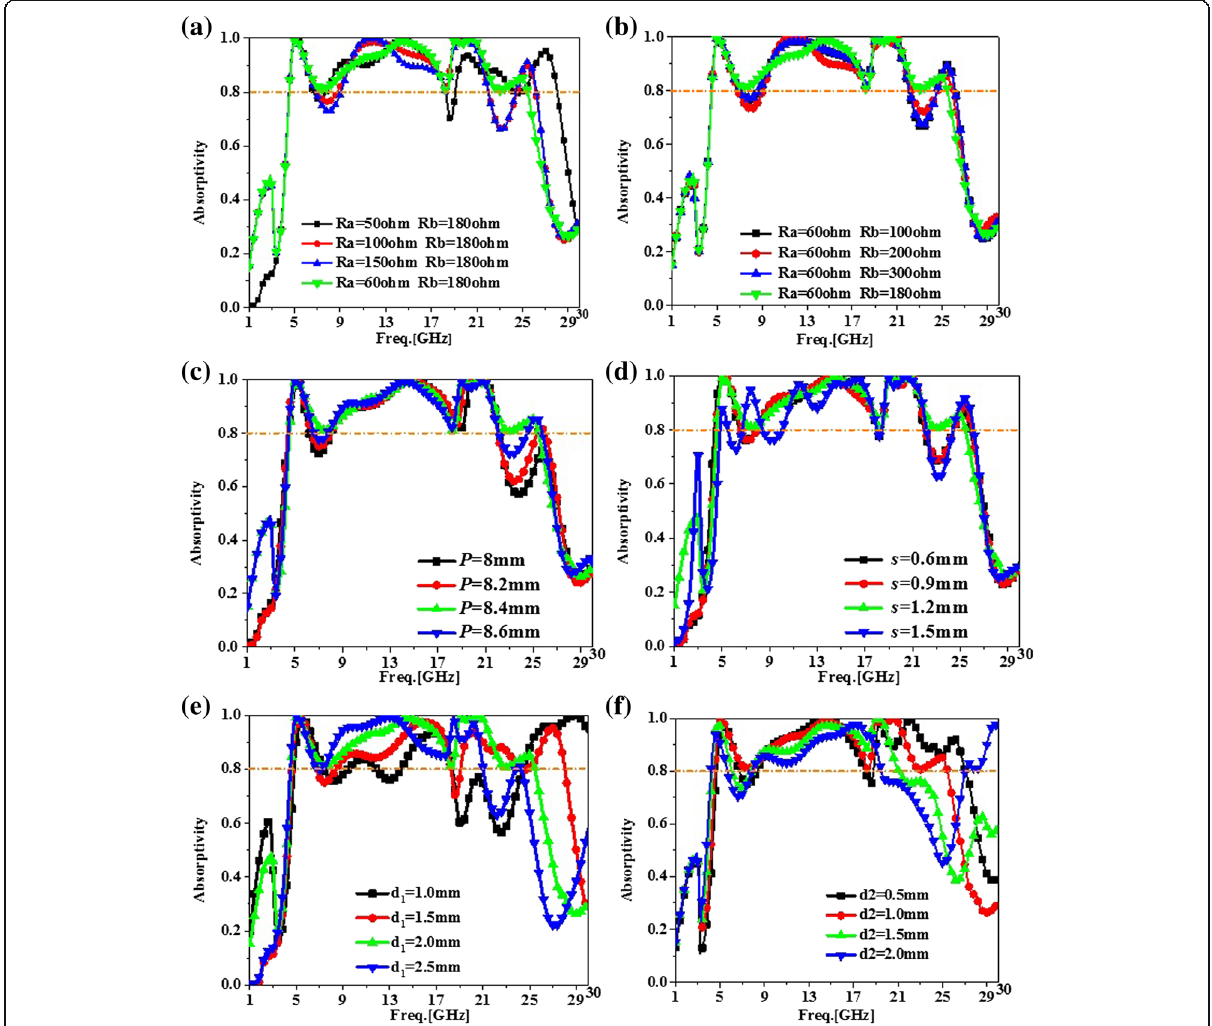
Fig. 3 Absorption results from 1 to 30GHz for the proposed ultra-wideband perfect metamaterial absorber with different parameters. a Absorption results of the PMA with different R a values. b Absorption results of the PMA with different R b values. c Absorption results of the PMA with different lengths of P . d Absorption results of the PMA with different lengths of s . e Absorption results of the PMA with different thicknesses of d 1 . f Absorption results of the PMA with different thicknesses of d